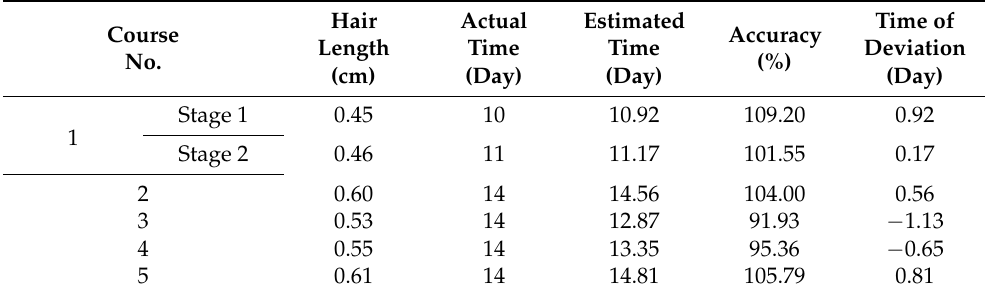
Table 4. Estimation results of continuous days of As 2 O 3 administration in each course for patient No. 8.